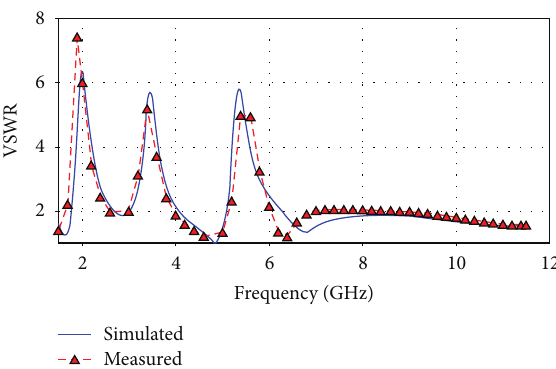
Figure 8: The measured and simulated VSWR of the proposed triple band-notched antenna.